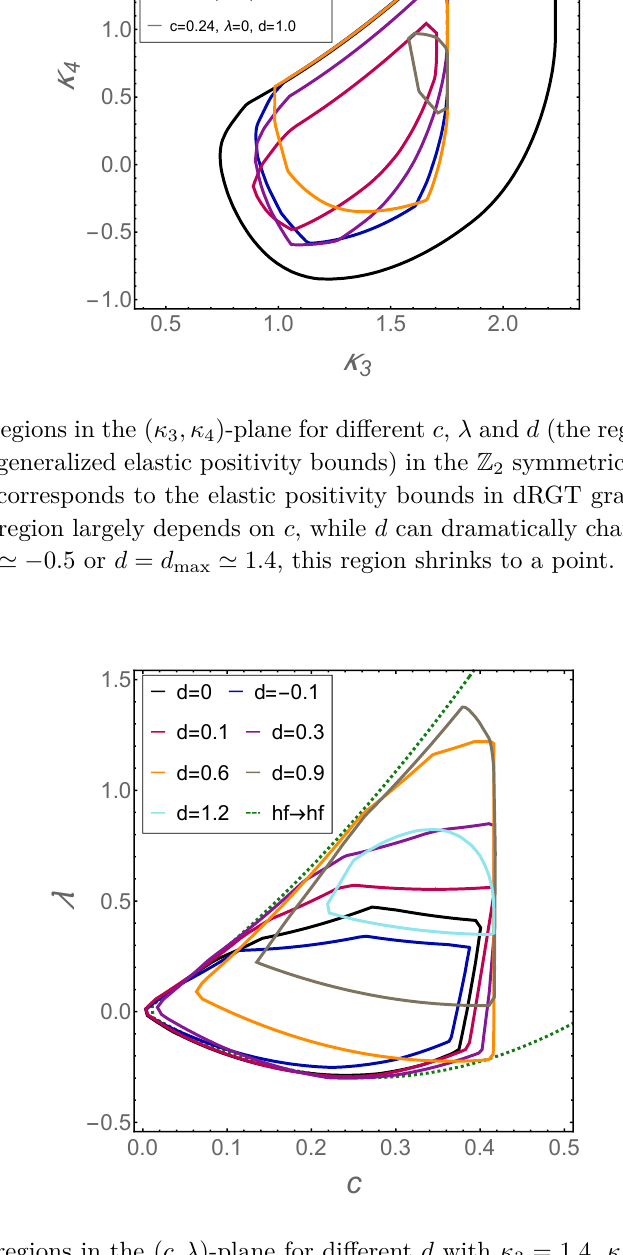
symmetric case. 2